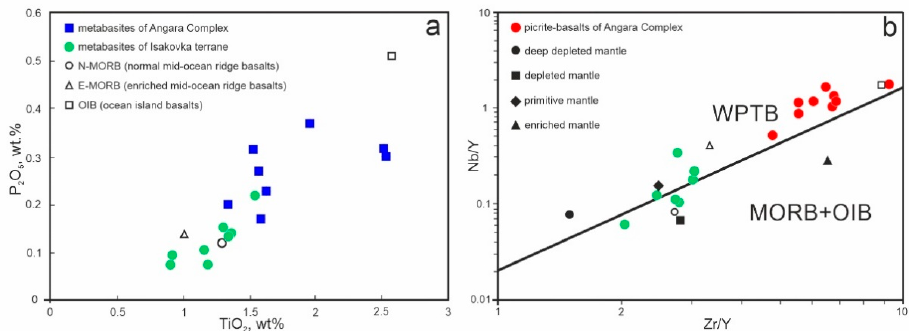
Figure 35. P 2 O 5 –TiO 2 ( a ) and Nb/Y–Zr/Y ( b ) diagrams for metabasites of the Angara area Complex as compared to the metabasites of Isakovka terrane and the main types of basalts: N-MORB, OIB, and E-MORB. Mantle components: (DEP) deep depleted mantle, (DM) depleted mantle, (PM) primitive mantle, and (EN) enriched mantle. Inclined line separates the field of within-plate basalts (upper part of the figure) from MORB and island-arc volcanic rocks (lower part).